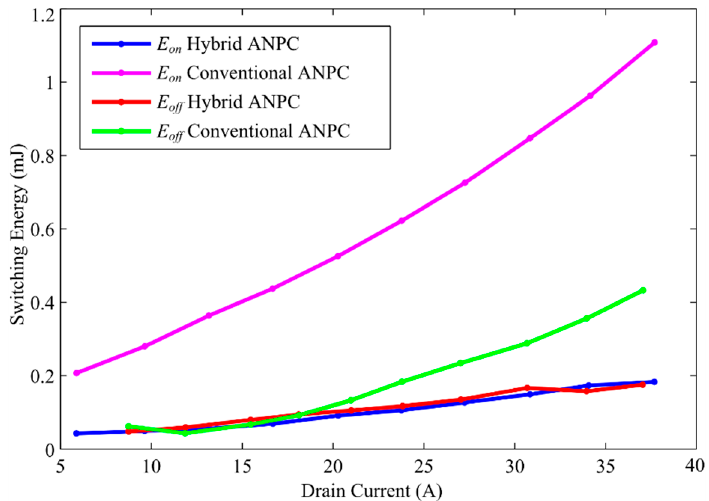
Figure 10. Characteristics curves highlighting the energies required for switches to turn ON and turn OFF with respect to the switching current for conventional ANPC and hybrid ANPC inverters.